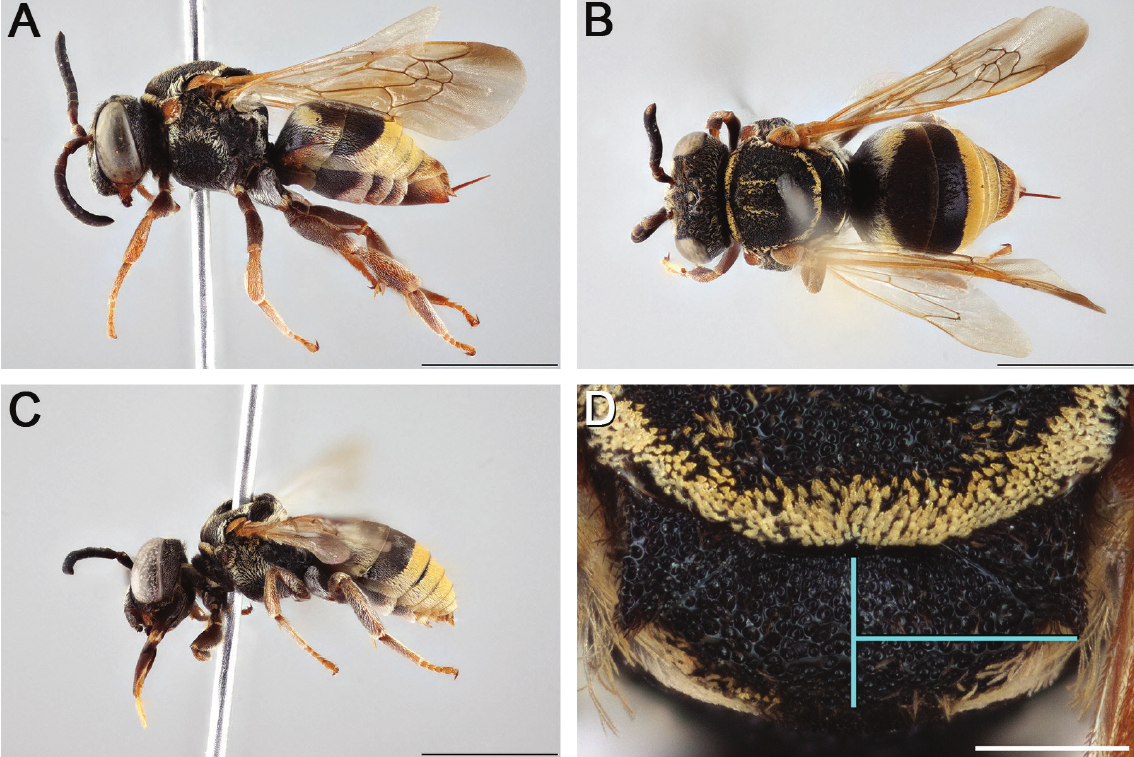
Fig. 14. Epeolus luteipennis Friese, 1916. A . Female, habitus, lateral view. B . Female, habitus, dorsal view. C . Male, habitus, lateral view. D . Female axillae and mesoscutellum, dorsal view (blue lines indicate the posterior extent of the axilla relative to the length of the mesoscutellum). Scale bars: A–C = 3 mm; D = 0.5